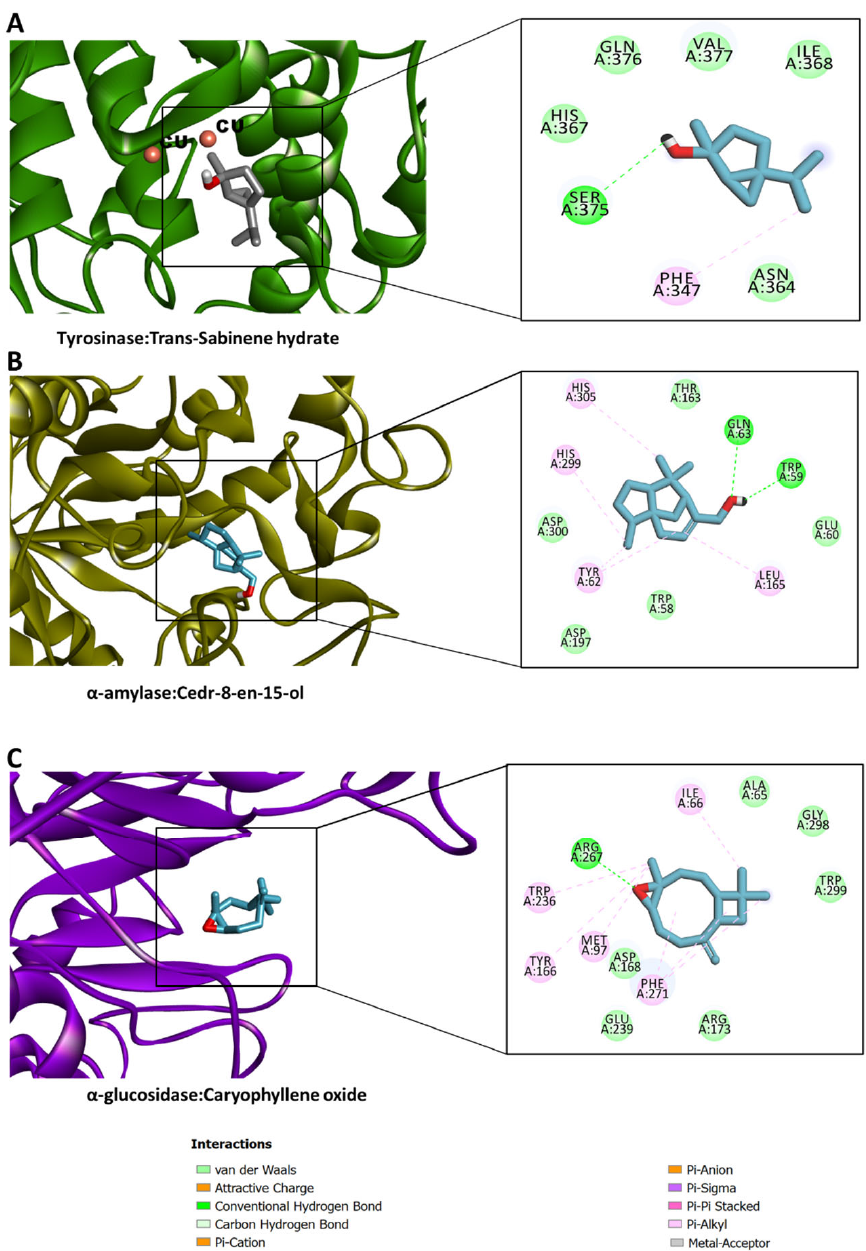
Figure 6. Protein–ligand interaction: ( A ) tyrosinase and trans ‑sabinene hydrate, ( B ) α ‑amylase and cedr‑8‑en‑15‑ol, and ( C ) α ‑glucosidase and caryophyllene oxide. These phytochemical compounds were extracted from C. obtusa, C. nigritanus and L. coronopifolia.